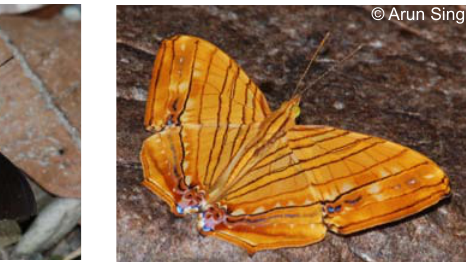
Image 47b. Dark Archduke Lexias dirtea khasiana (male)